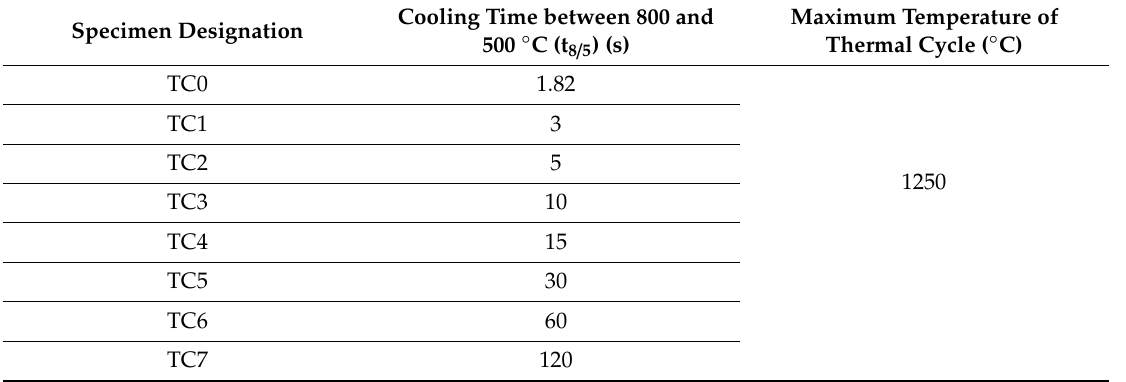
Table 4. Parameters of imposed thermal cycles with variable cooling time between 800 and 500 ◦